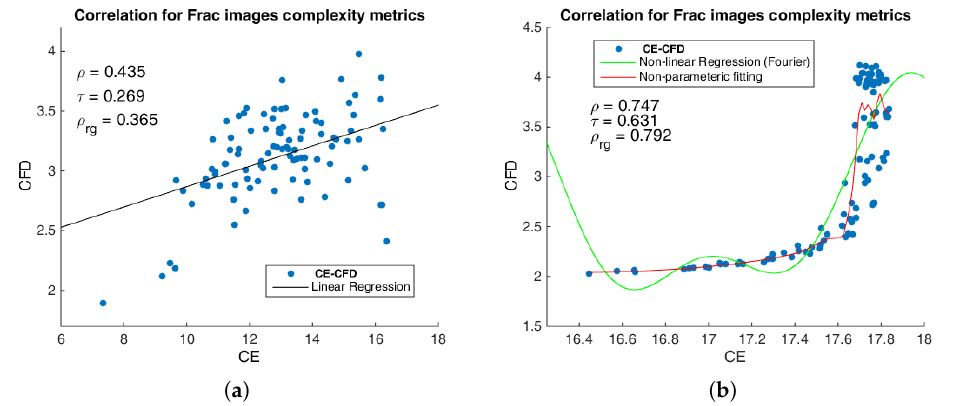
Figure 3. Color Entropy versus Color Fractal Dimension for ( a ) Nat and ( b ) Frac textures in terms of Pearson, Kendall’s Tau, and Spearman’s rank correlation